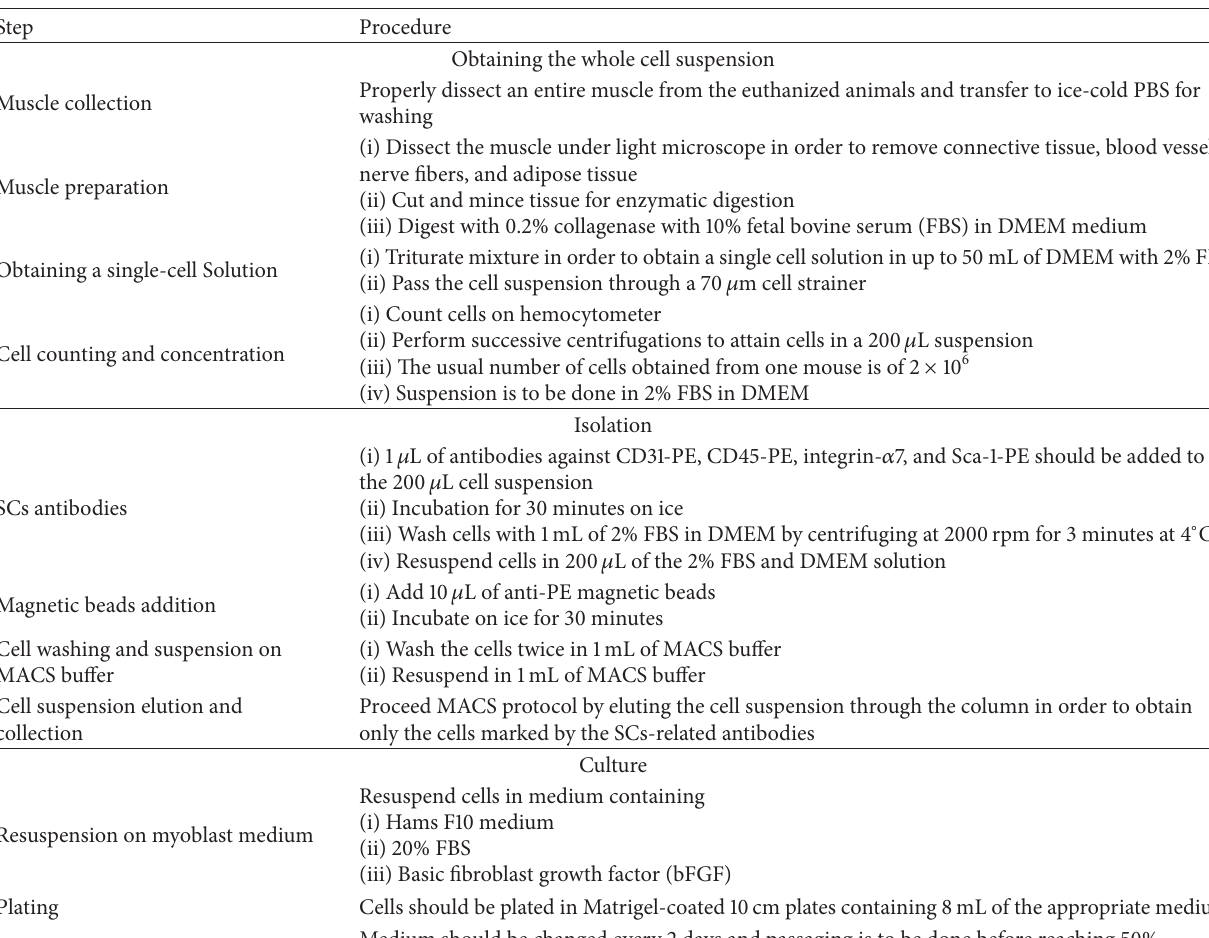
Table 2: Summarized protocol for isolation and culture of SCs on